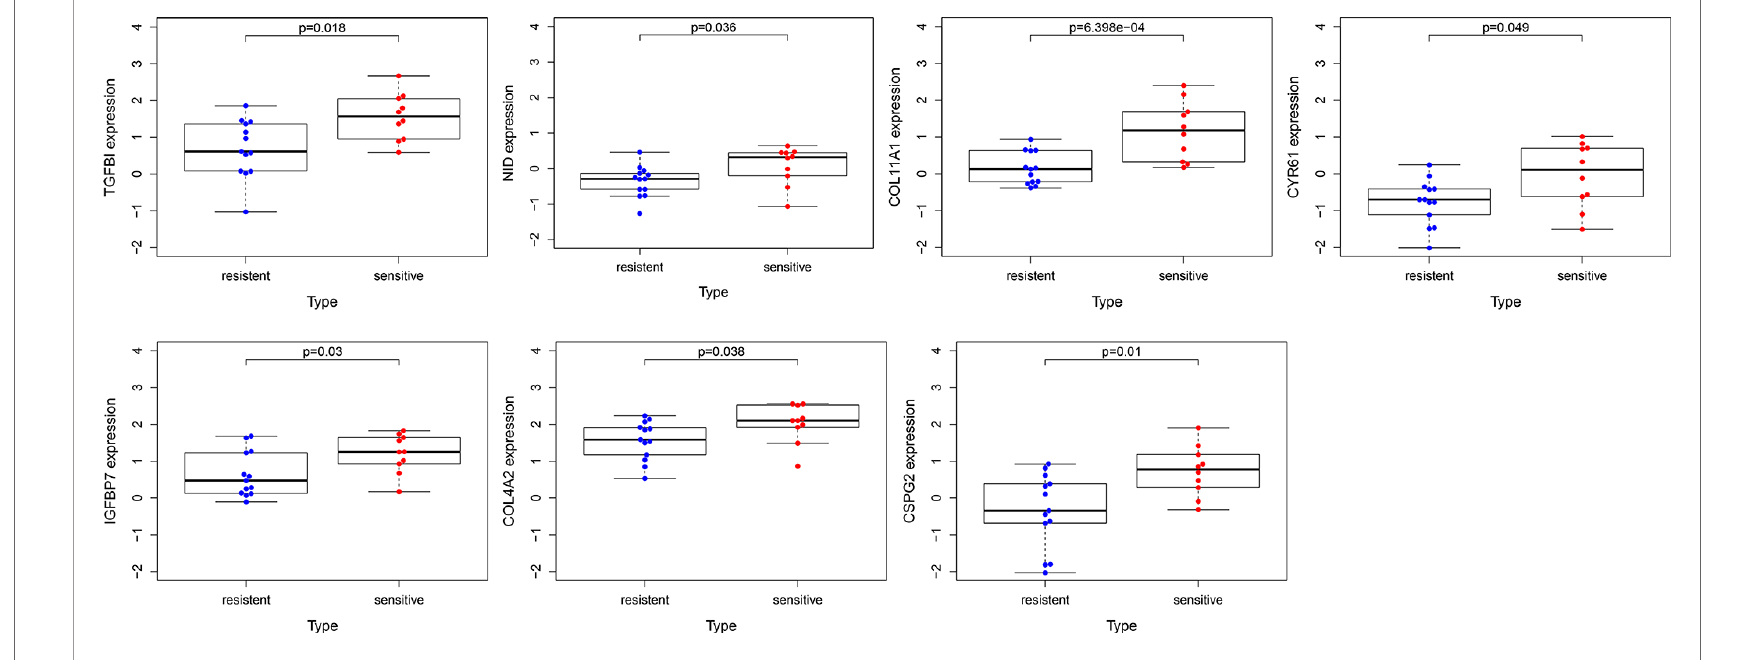
FIGURE 8 | The expression of hub genes between chemotherapy-resistant samples and chemotherapy-sensitive